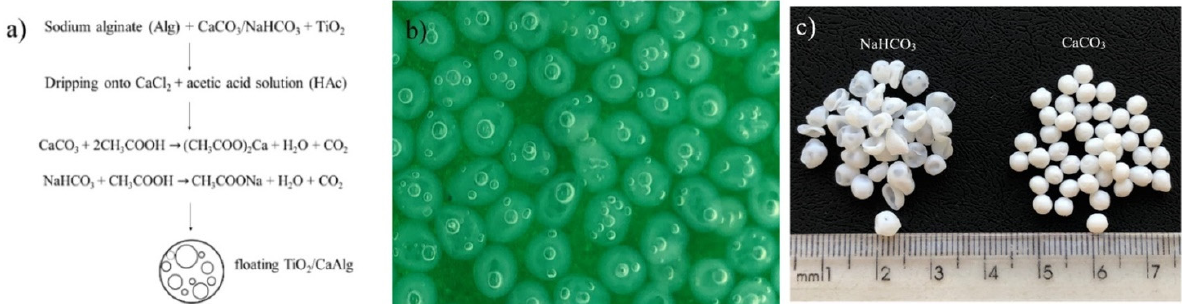
Figure 6. ( a ) Scheme from ionotropic gelation and CO 2 generation from both gas forming agents (CaCO 3 and NaHCO 3 ), ( b ) bubbles held within the gel beads with CaCO 3 in its formulation, and ( c ) floating TiO 2 /CaAlg beads with 1:1 ratio of NaHCO 3 /alginate and 1:1 ratio of CaCO 3 /alginate [33].